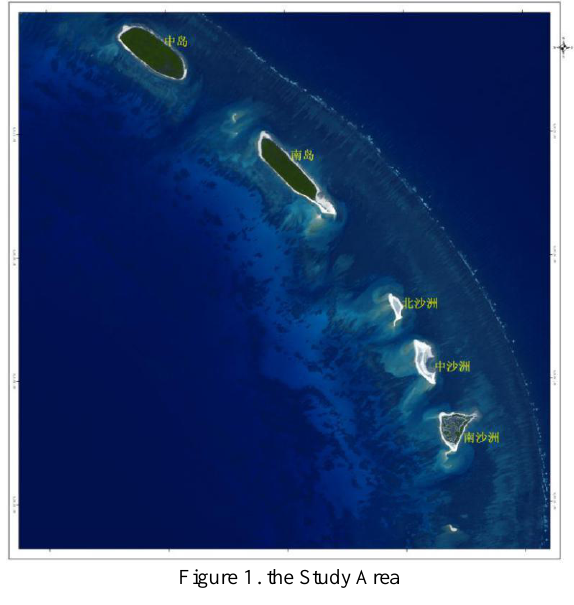
Figure 1. the Study Area